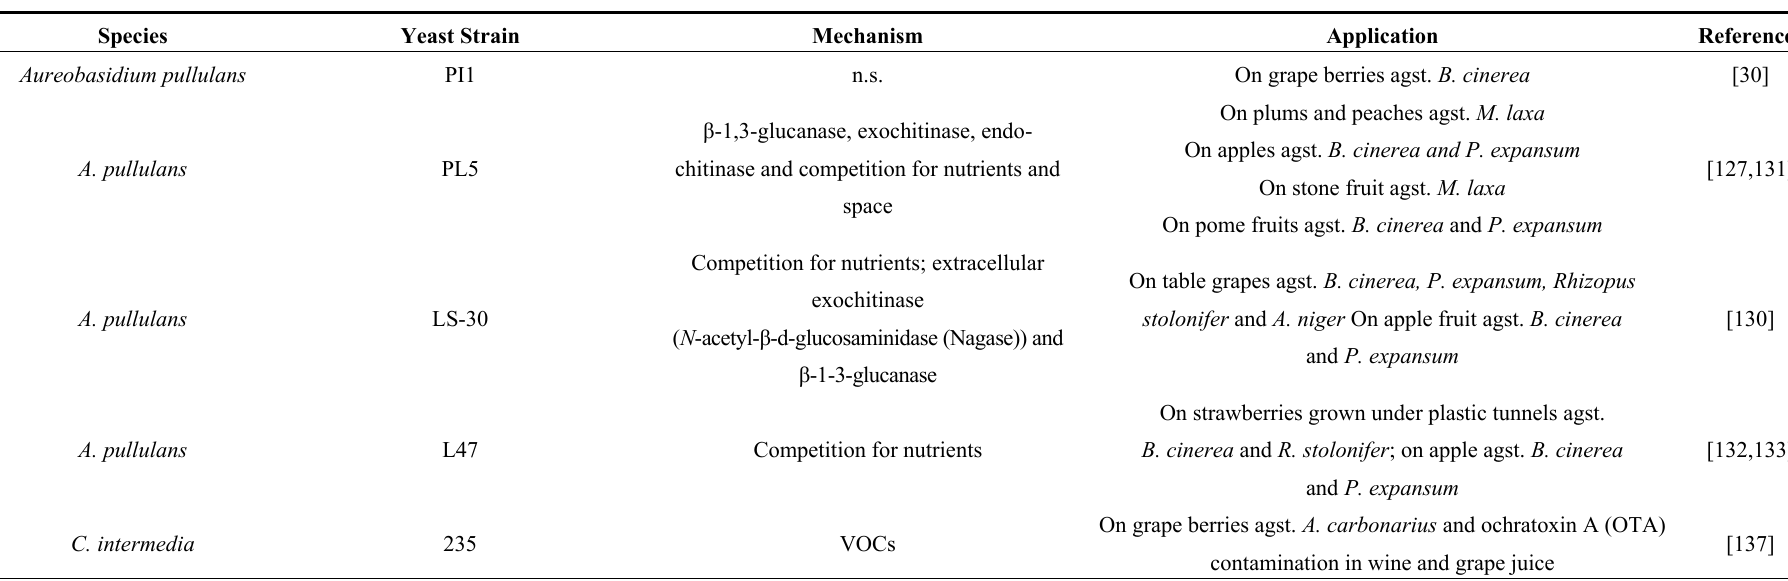
On table grapes agst. B. cinerea, P. expansum,